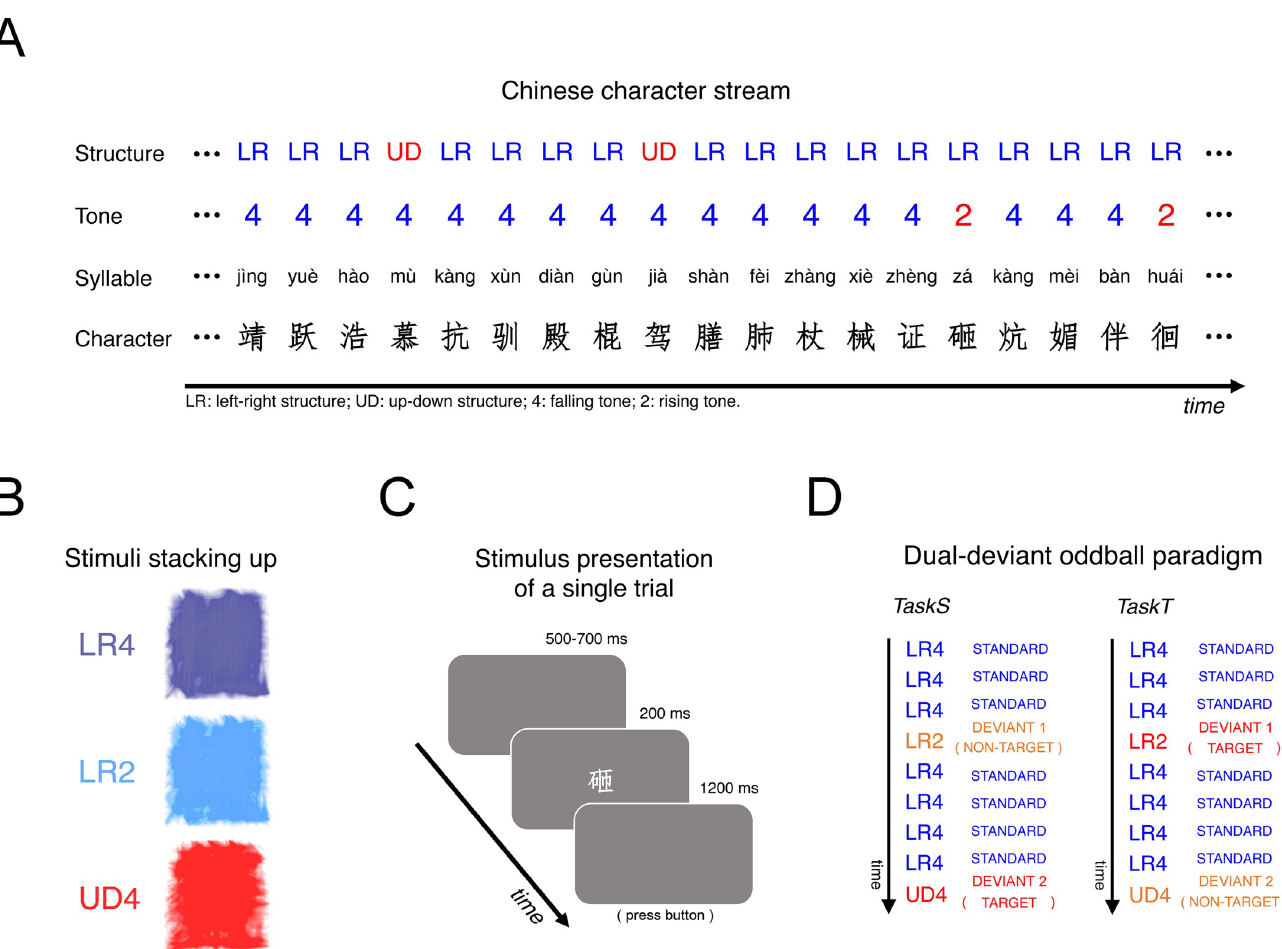
Fig 1. Experimental protocol and stimuli. (A) We adopted an active oddball paradigm with two types of deviant stimuli that violated abstract patterns of structural and tonal features of Chinese characters respectively. The standard stimuli were Chinese characters with left-right structure and falling tone (LR4). The two types of deviant stimuli were characters with up-down structure and falling tone (UD4) and characters with left-right structure and rising tone (LR2). The patterns of structural and tonal features abstract were abstract, since the characters were constructed with various radicals and their pronunciations contained various consonants and vowels. (B) Chinese characters stacking-up for the three stimulus types. Note they are considerably similar, suggesting minimal physical heterogenicity of visual stimuli. (C) The duration of the presence of each character was 200 ms and the stimulus onset asynchrony was 1.9–2.1 s. (D) The experiment included two sessions where exactly the same stream of characters was presented. In one session, subjects were instructed to respond to the deviant stimuli that violated the abstract structural pattern by pressing a button and neglected the other type (TaskS); in the other session, they were instructed to respond to the deviant stimuli that violated the abstract tonal pattern by pressing a button (TaskT).